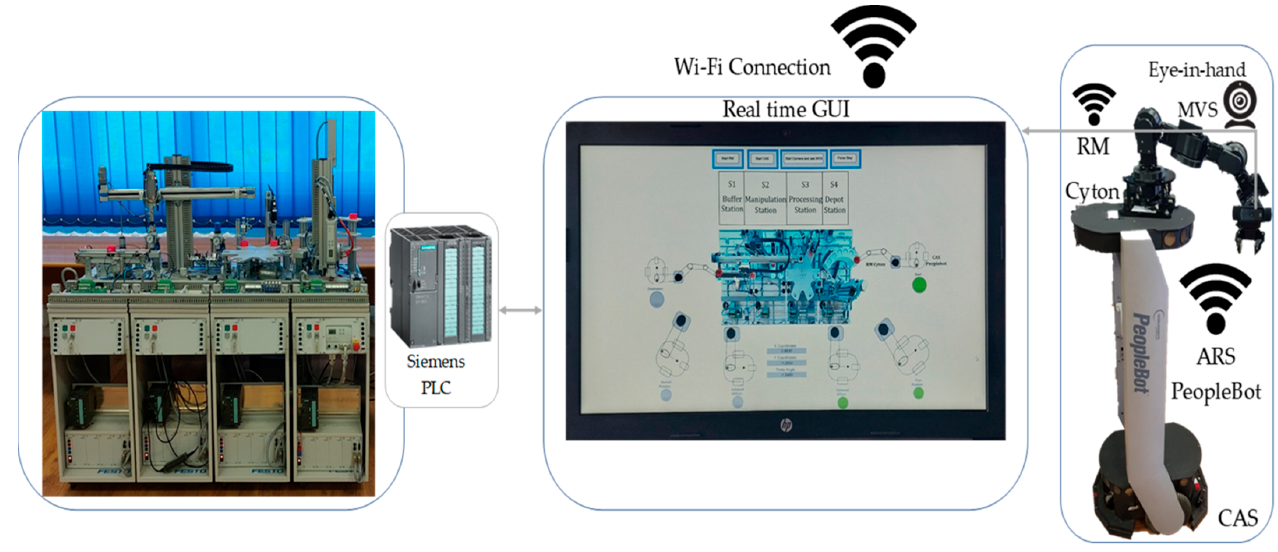
Figure 11. Communication block set of the P/RML, CAS and computer.